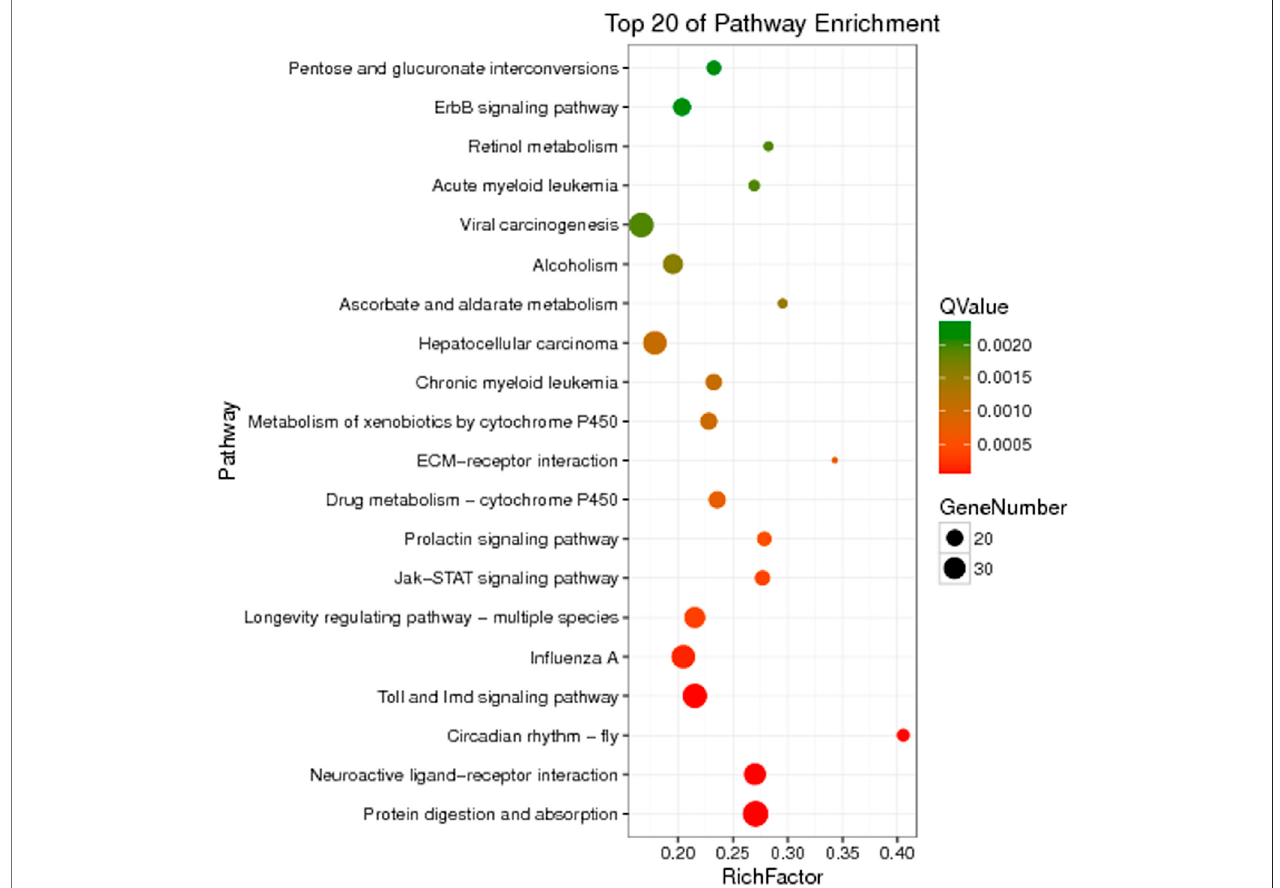
FIGURE 4 | KEGG enrichment analysis results of speci fi c genes of Ceratitis capitata (Wiedemann).